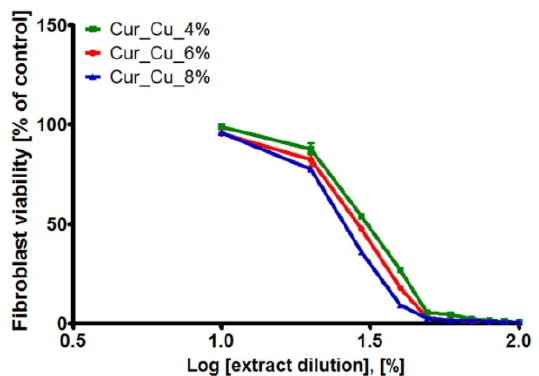
Figure 8. The cytotoxic activity of extracts obtained from Cur_Cu_4%, Cur_Cu_6%, and Cur_Cu_8% biomaterials. The initial extracts (100%) were diluted in fresh Eagle’s Minimum Essential Medium (EMEM) (90–10%) in order to determine skin fibroblast (BJ cell line) response to extract solutions at different concentrations.